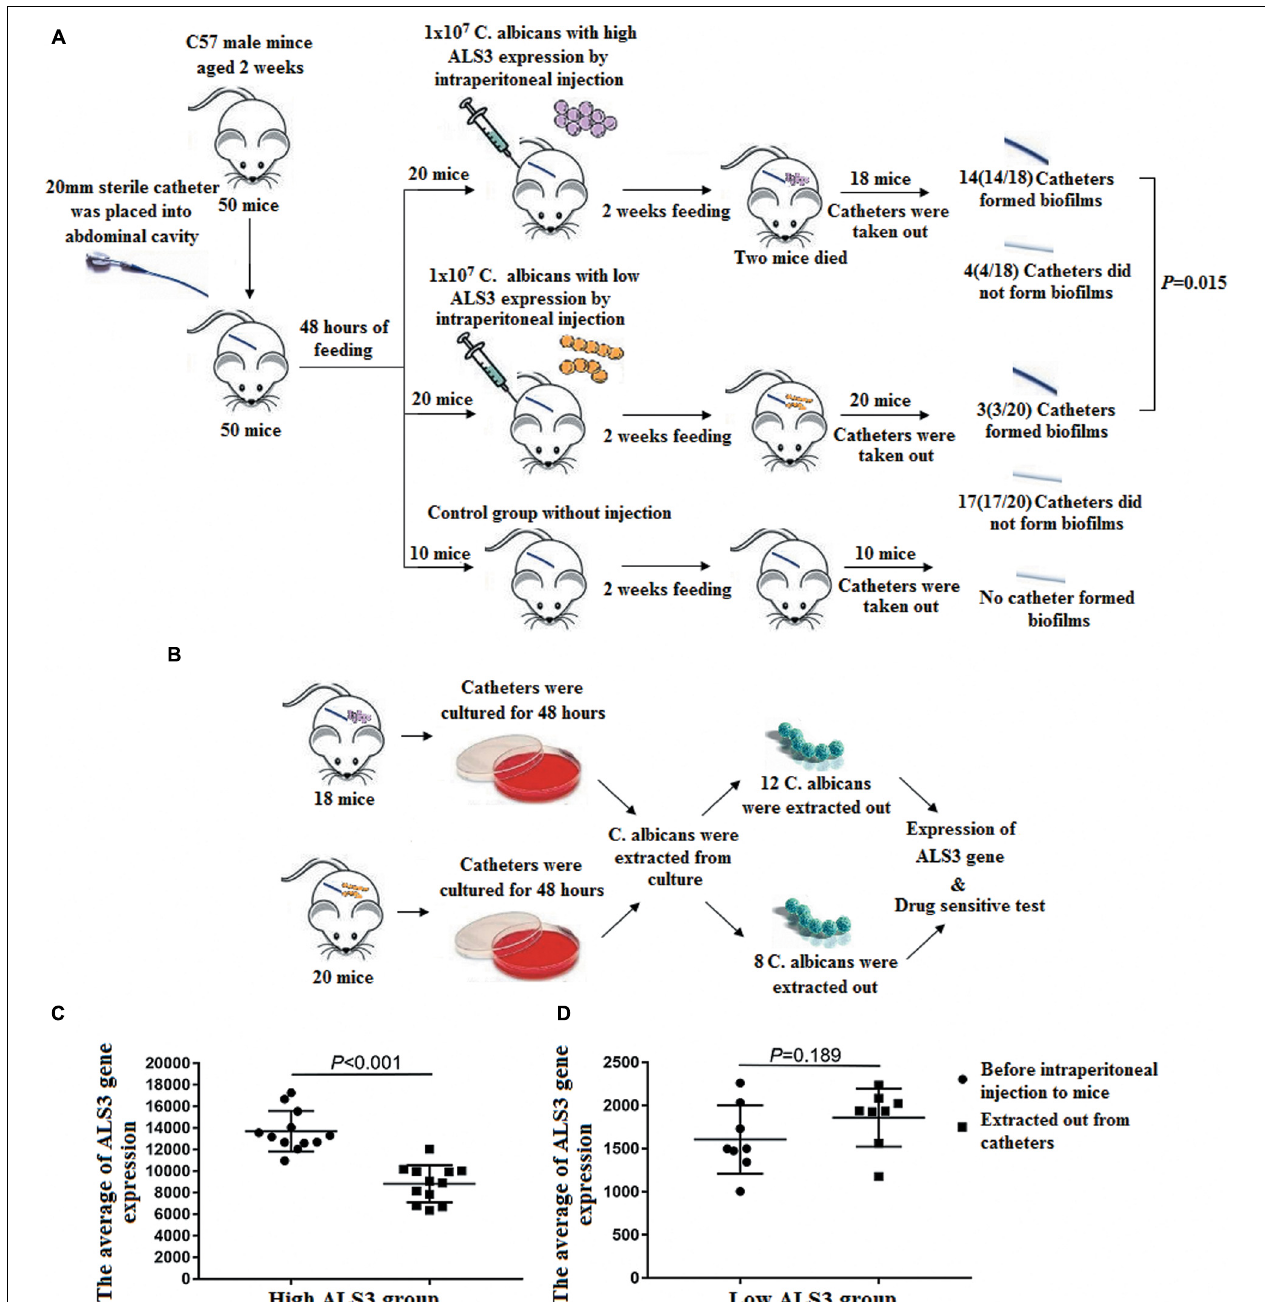
FIGURE 4 | Biofilm formation in mice. (A) A total of 14 C. albicans (14/18, 77.8%) in the high ALS3 gene expression group formed biofilms. Three C. albicans strains (3/20, 15%) in the low ALS3 gene expression group formed biofilms ( P = 0.000). (B) After the catheters were cultured, there were 12 C. albicans strains from the catheters of the high ALS3 expression group and the eight C. albicans strains from the catheters of the low ALS3 expression group were isolated from culture in vitro . (C) The average of ALS3 gene expression in 12 C. albicans from the catheters of the high ALS3 expression group declined from 13710 ± 1839 to 8828 ± 1680 ( P < 0.001). (D) The average of ALS3 gene expression in eight C. albicans from the catheters of the low ALS3 expression group was 1860 ± 706. While before the biofilm formation experiment, it was 1607 ± 324 in this group ( P =